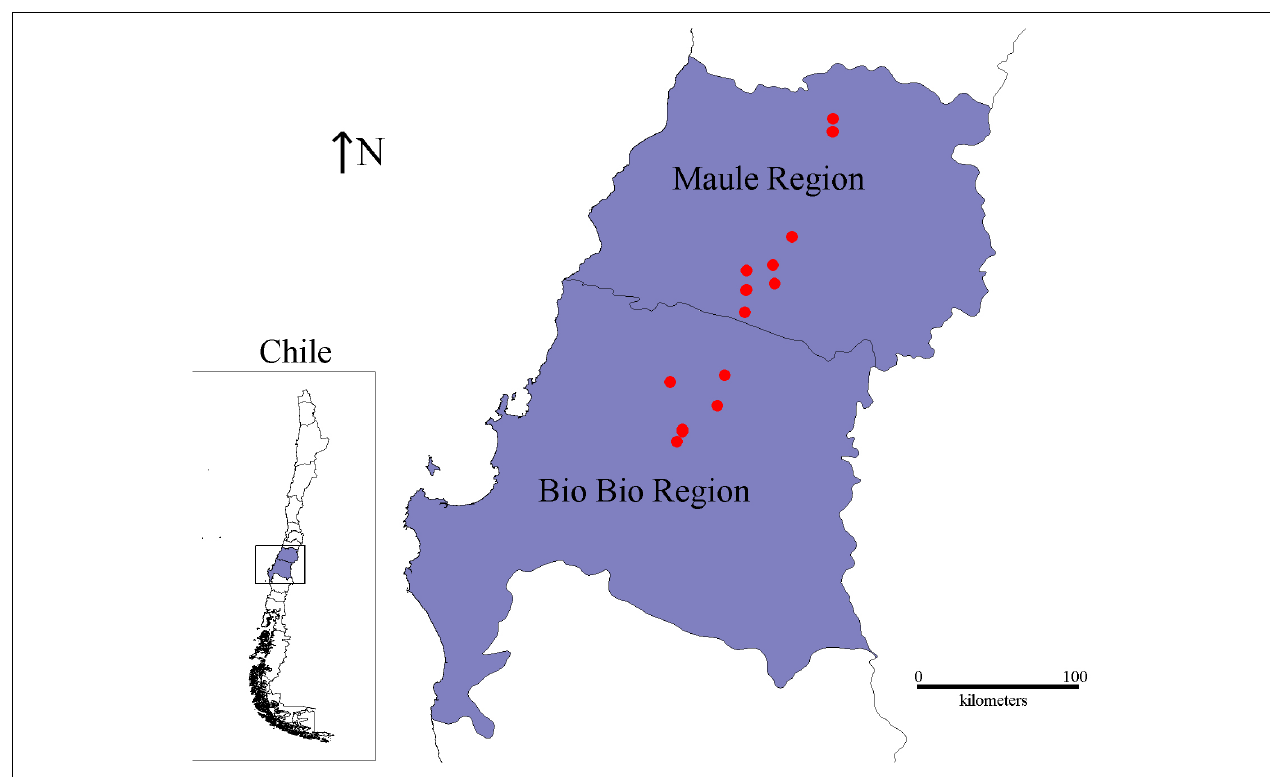
FIGURE 1 | Geographic localization of the Chilean Psa strains. The map shows the localization of the Maule and Bío Bío regions. The red spots represent the exact location from where the Chilean Psa strains were isolated.